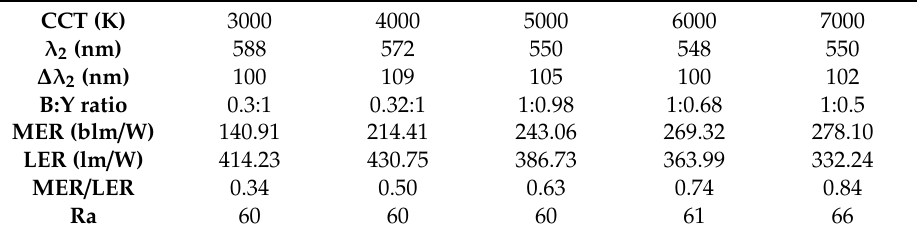
Table 2. Spectral characteristics with minimum MER / LER from 3000 to 7000